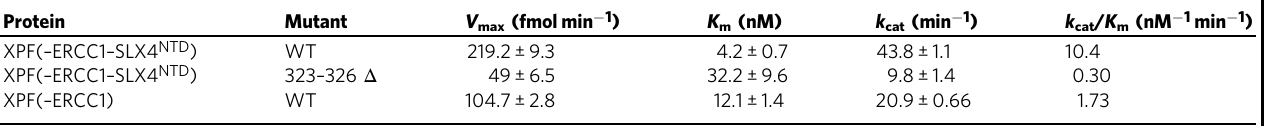
Each kinetic value was obtained from 3 technical replicates ( n = 3) ± the standard deviation